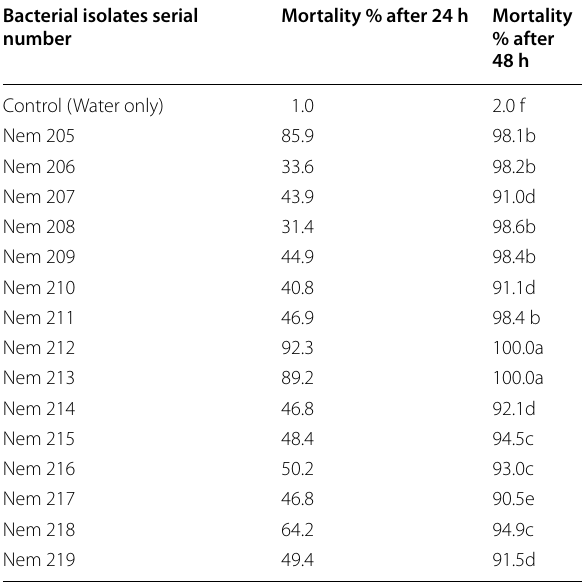
Table 2 Nematicidal activity of the cell‑free filtrates of 15